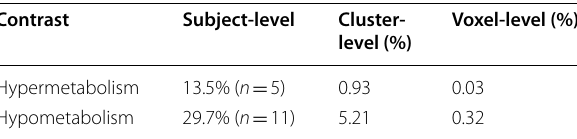
Cluster-level and voxel-level results are reported at p < 0.05 FWE. The denominator for subject-level is the total number of participants; the denominator for the cluster-level is the average number of resolution elements in the mask; the denominator for the voxel-level is the number of voxels in the SPM mask. See Methods for